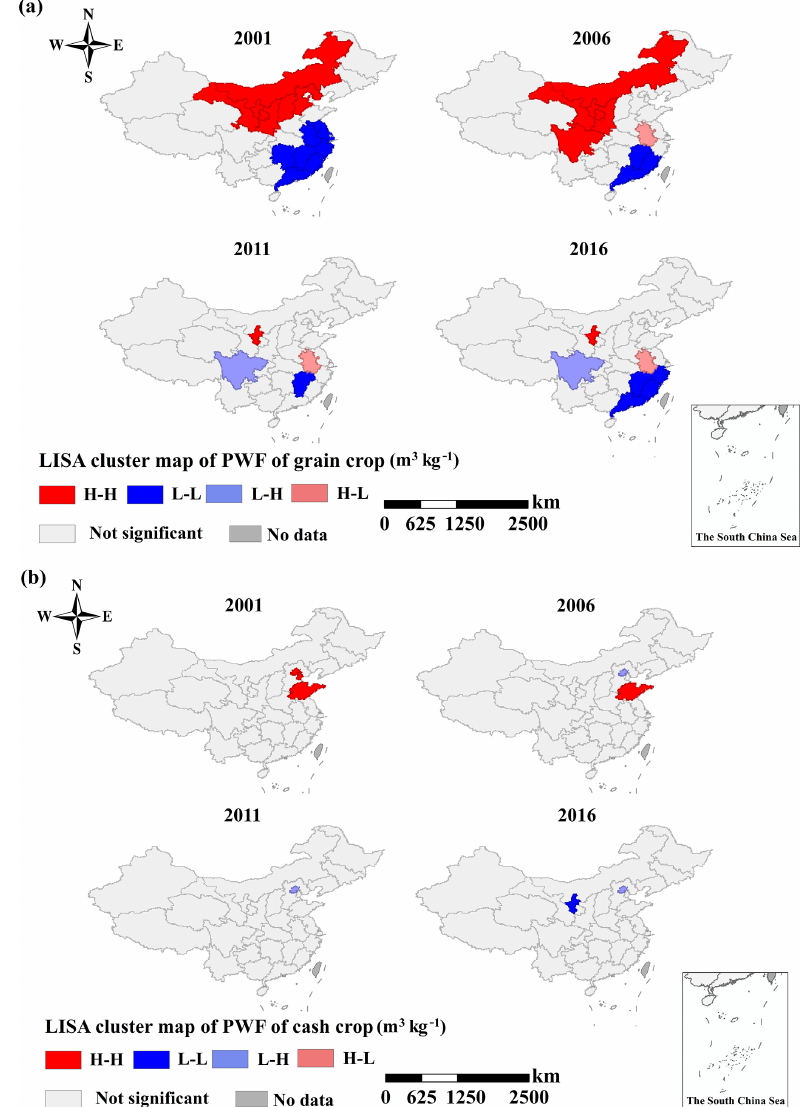
Figure 4. The LISA cluster maps of production-based water footprint (PWF) of (a) grain and (b) cash